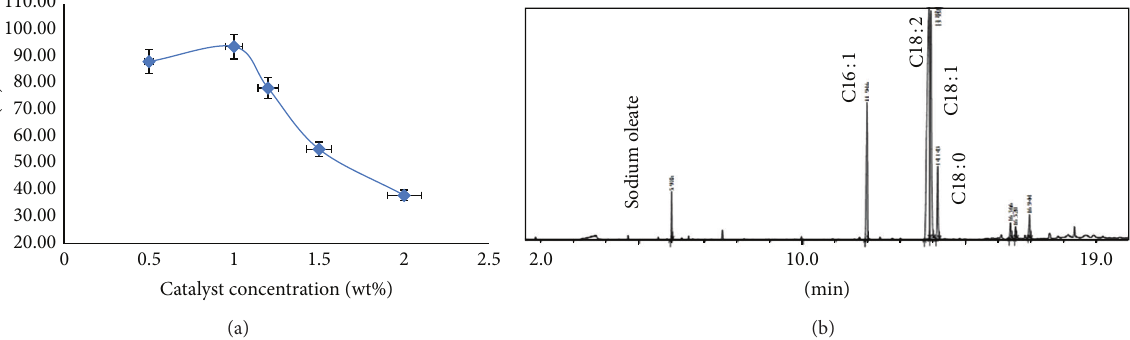
Figure 3: (a) Effect of NaOH concentration with respect to oil weight on percentage biodiesel yield. (b) GC-MS of biodiesel produced using 2% NaOH catalyst